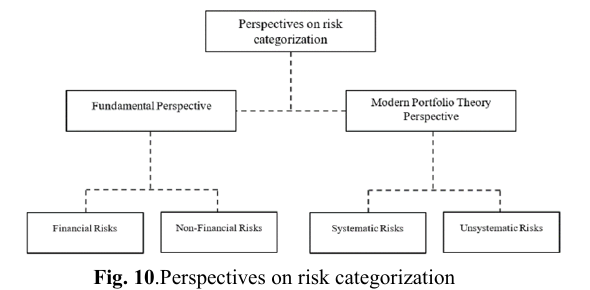
Fig. 10 .Perspectives on risk